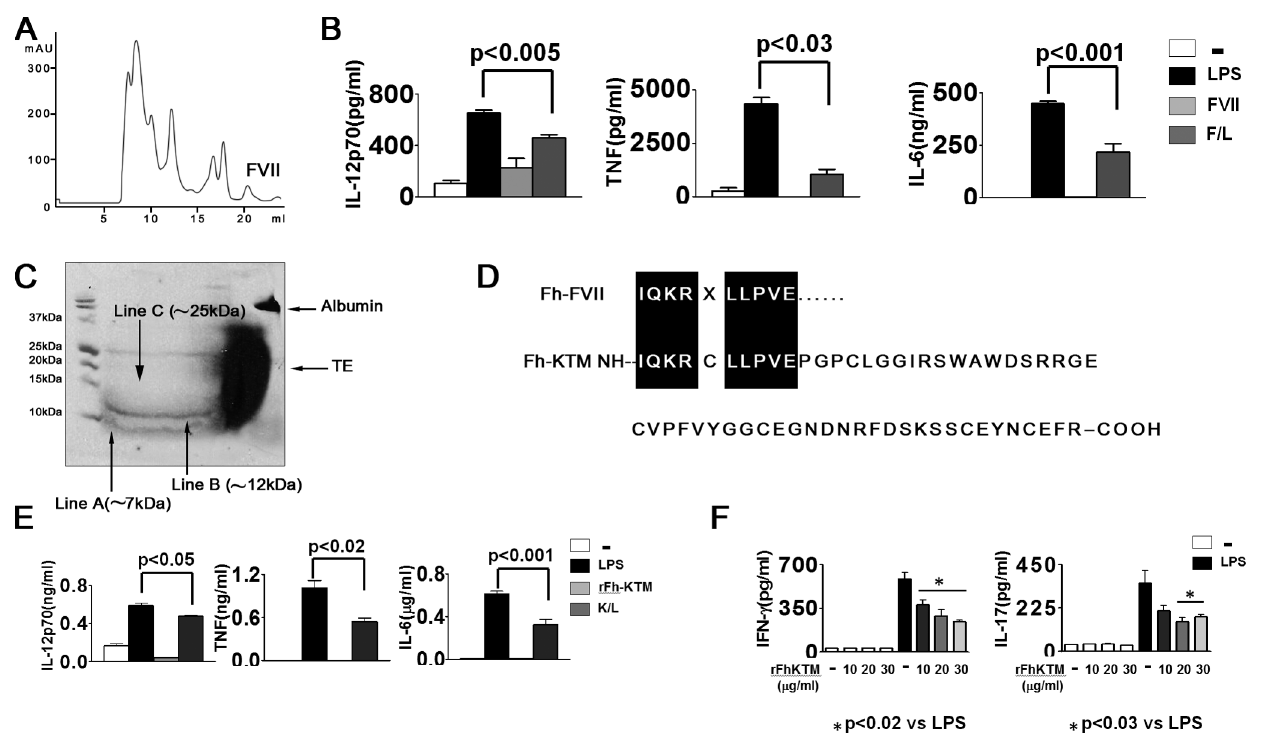
Fig. 3. Kunitz type protease inhibitor present in FVII modulates TLR-induced DC activation (A). Elution profile of TE fractionated by Superdex G75. (B) IL-12p70, TNF and IL-6 production were detected by ELISA in the supernatants of DC cultured with medium, LPS (1 m g/mL), FVII (10 m g/ml) or FVII plus LPS (F/L) for 18 h. (C) FVII was resolved in 18% SDS-PAGE gel and stained with amido black (D) Comparison of the N-terminal sequences obtained for FVII and F. hepatica KTM. (E) DC were incubated with medium or rFh-KTM (20 m g/ml) in the presence or absence of LPS (1 m g/ml), and after 18 h the cytokine production was evaluated in the supernatants by ELISA. (F) IFN- c and IL-17 were detected in the supernatant of DC from BALB/c mice treated with medium, LPS, rFh-KTM (10, 20 and 30 m g/ml) or rFh-KTM plus LPS for 18 h, and cultured with C57BL/6 splenocytes at a 1:10 ratio for 5 days. Data are means ¡ SD of at least five wells and are representative results from two or three experiments. p represents a significant difference in the Student’s t-test.